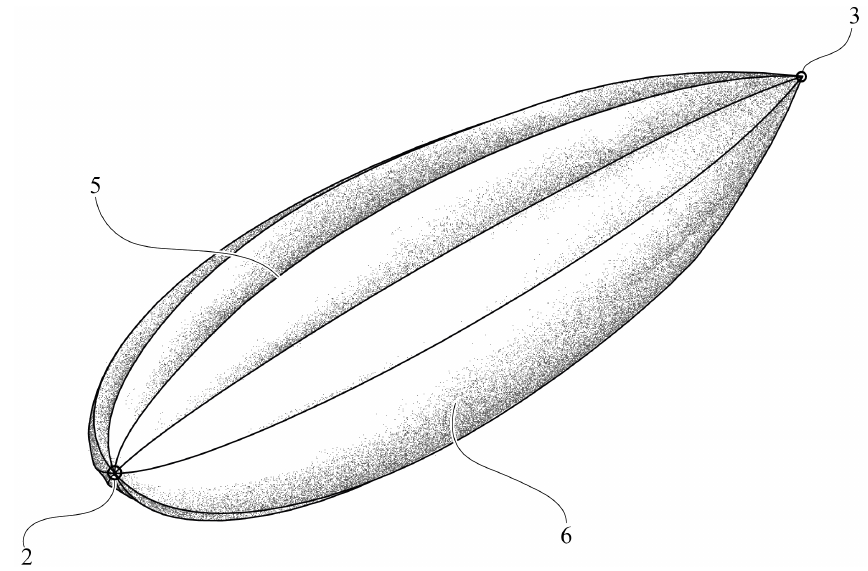
Figure 16. Bioinspired shell. Colombian Patent NC2019/000840